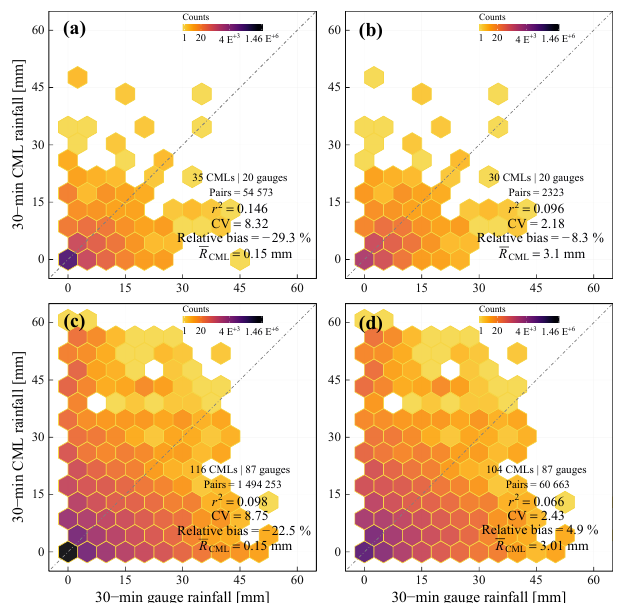
Figure 6. Scatter density plots of half-hourly CML rainfall depths vs. gauge rainfall depths from 20 October 2014 to 9 January 2015. Panels (a, b) is for the analysis up to 1km in the vicinity of the selected CMLs. Panels (c, d) is for the analysis up to 9 . 1km in the vicinity of the selected CMLs. As noted in the inset metrics, the number of CMLs vary given the selection of the vicinity/radius. Panels (a, c) is for the analysis of all rainfall pairs, i.e. zeros in- cluded. Panels (b, d) is for the analysis of those pairs in which both rainfall depths are above zero (i.e. rainy events). The colour scale is logarithmic.